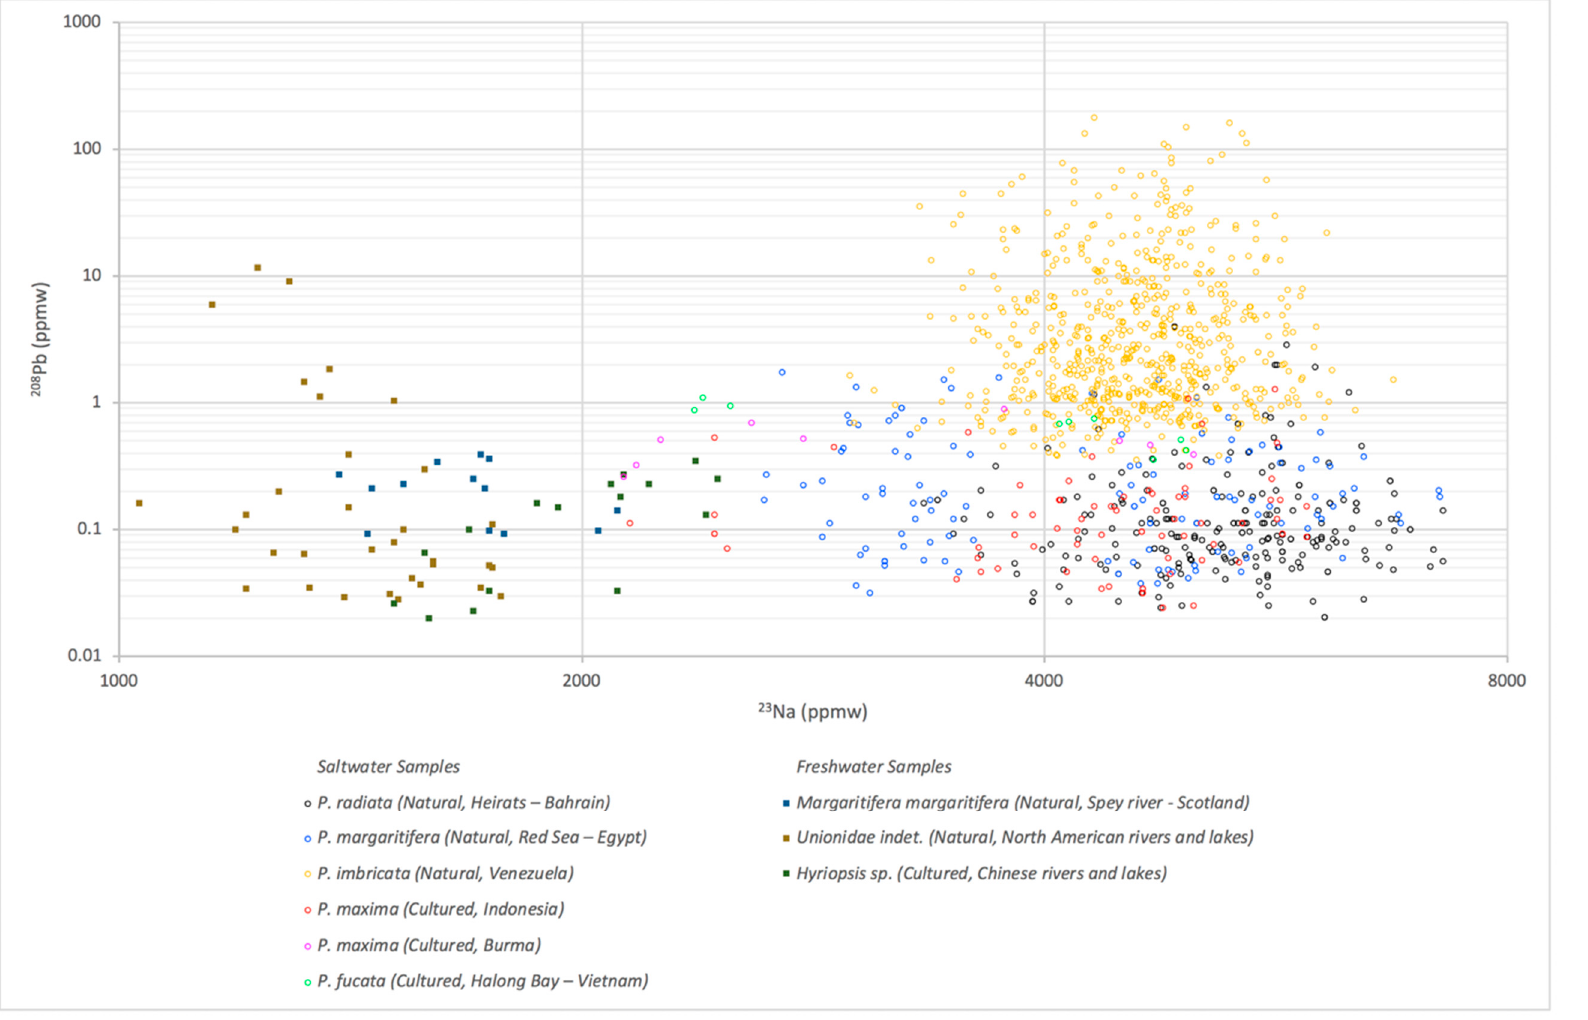
Figure 5. Binary plot of 23 Na vs. 208 Pb of the studied samples.